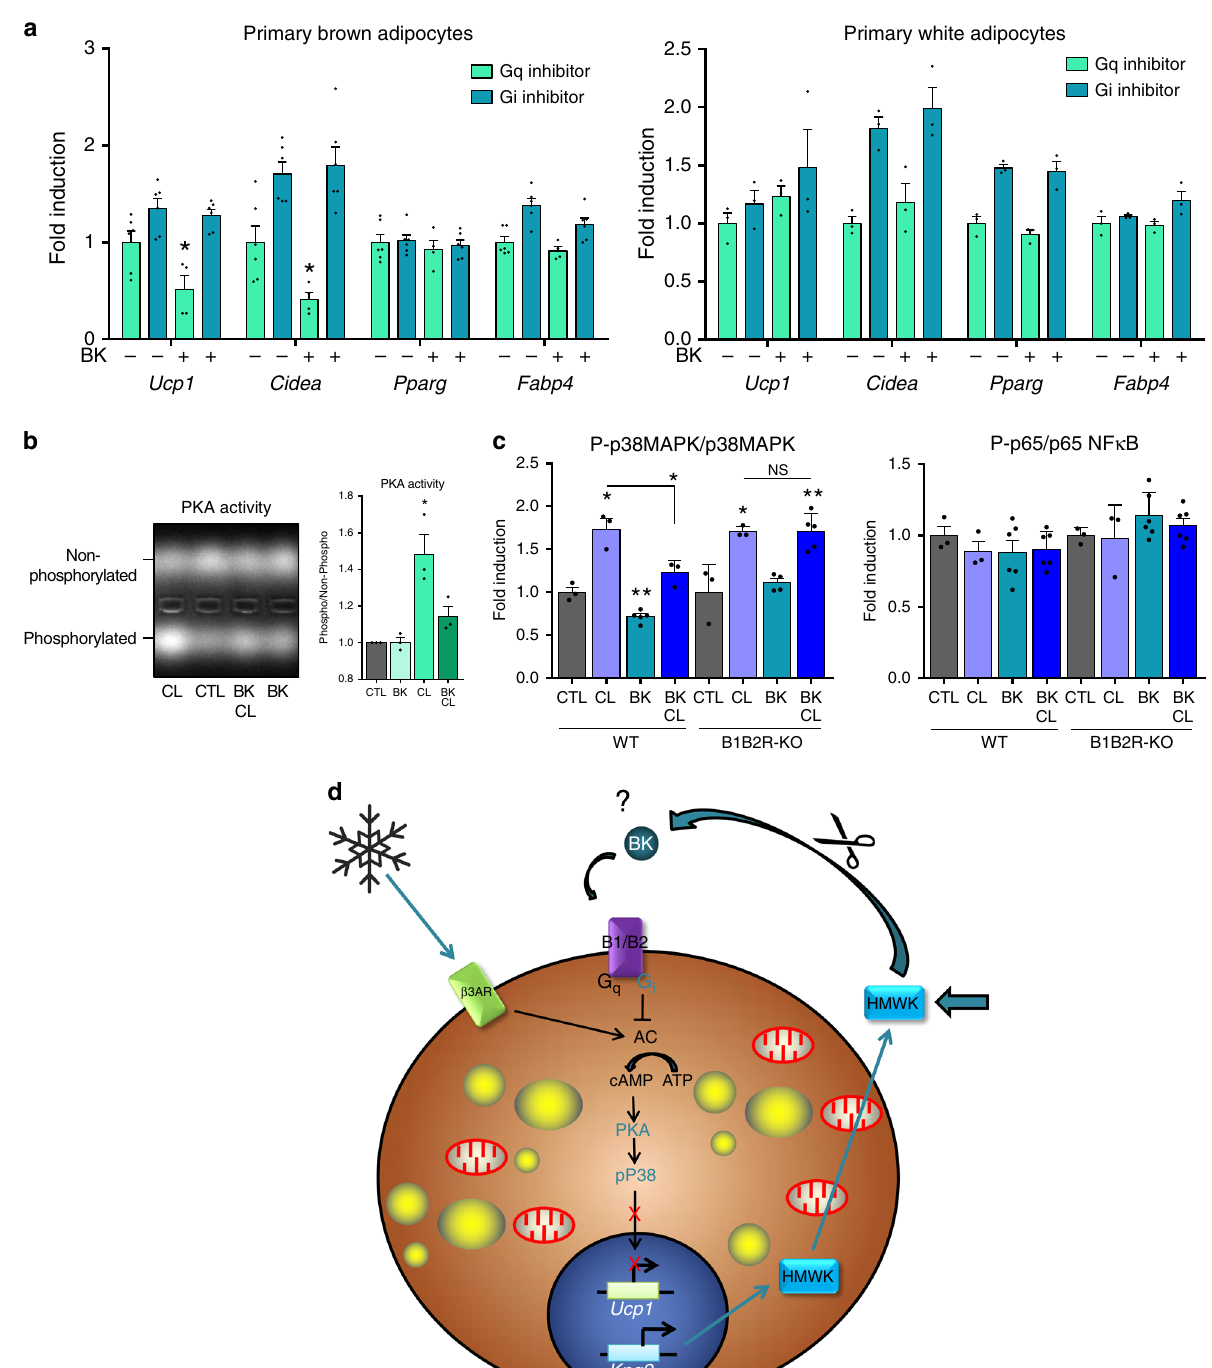
Fig. 10 Regulation of thermogenic pathways by the kallikrein – kinin system. a mRNA expression of genes involved in thermogenesis and adipogenesis in primary brown ( n = 6 independent cell culture experiments, except for G q /BK condition where n = 4) and white adipocytes ( n = 3 independent cell culture experiments) exposed to G q/i inhibitors in presence or absence of bradykinin for 24 h. b Protein kinase A activity in primary brown adipocytes exposed to bradykinin, CL316243 or both for 15 min. Representative picture of electrophoresis assay of phosphorylated and non-phosphorylated PKA substrate and quanti fi cation ( n = 3 independent cell culture experiments). c Phosphorylation status of p38MAPK ( n = 3 independent cell culture experiments, except for WT BK where n = 5 and B1B2R-KO BK and BK/CL where n = 4 and n = 6, respectively) and p65 NF κ B ( n = 3 independent cell culture experiments, except for WT and B1B2R-KO BK and BK/CL where n = 6) in primary WT and B1B2R-KO brown adipocytes exposed to CL316243, bradykinin or both for 15 min, normalized with total p38MAPK and p65 NF κ B. d Schematic representation of the effects of the kallikrein – kinin system in brown/beige adipocytes. Data are presented as means± s.e.m. (bars). * P < 0.05 and ** P < 0.01 versus corresponding controls; P -values determined by one way ANOVA with Tukey ’ s post hoc test ( c ) and two-tailed unpaired Student ’ s t-test ( a , b ). Source data are provided as a Source data fi